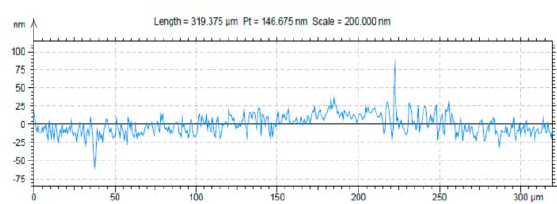
Fig. 2. Example of an imperfect surface profilogram.